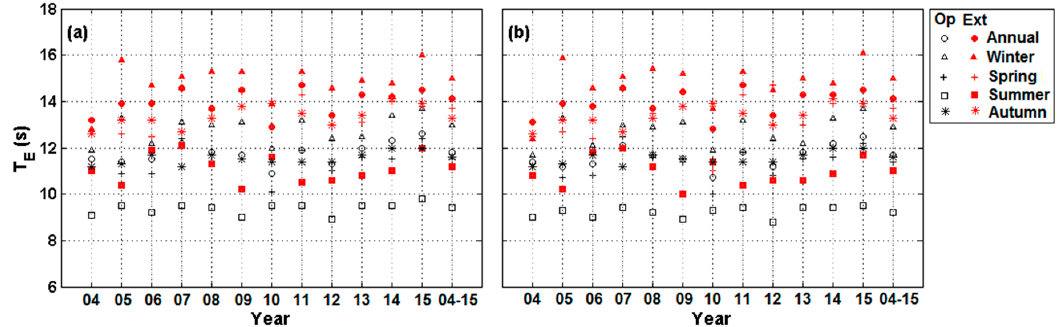
Figure 14. Annual and seasonal operational (Op) and extreme (Ext) T E thresholds (s) at ( a ) BA and ( b ) BB.